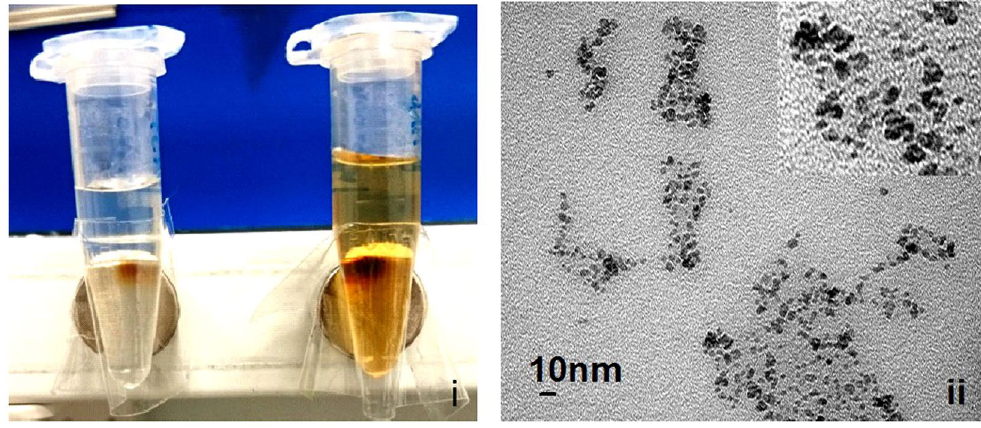
Figure 2. TEM images of ION (Resovist, ferucarbotran). Different concentrations of Resovist solution (i) colour images; left: 10 μ g/ml, right: 100 μ g/ml) magnetized using a permanent magnet. Particle size was 45–60 nm